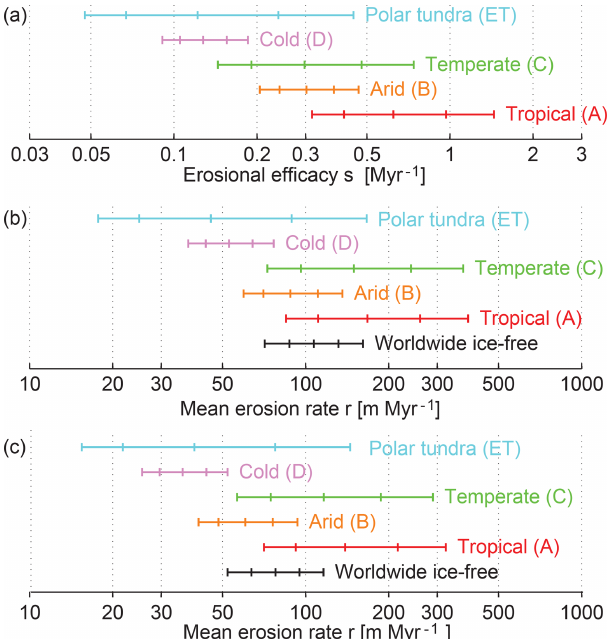
Figure 3. Erosion rates by climatic zones. (a) Mean erosional ef- ficacies of the primary Köppen–Geiger classes. (b) Respective ab- solute mean erosion rates for the predominantly erosive provinces. (c) Absolute mean erosion rates extrapolated to the entire ice-free surface including the classes platform, basin, and extended crust. Error bars represent 70% confidence intervals (corresponding to the standard deviation for a Gaussian distribution) and 95% confidence intervals (see Appendix